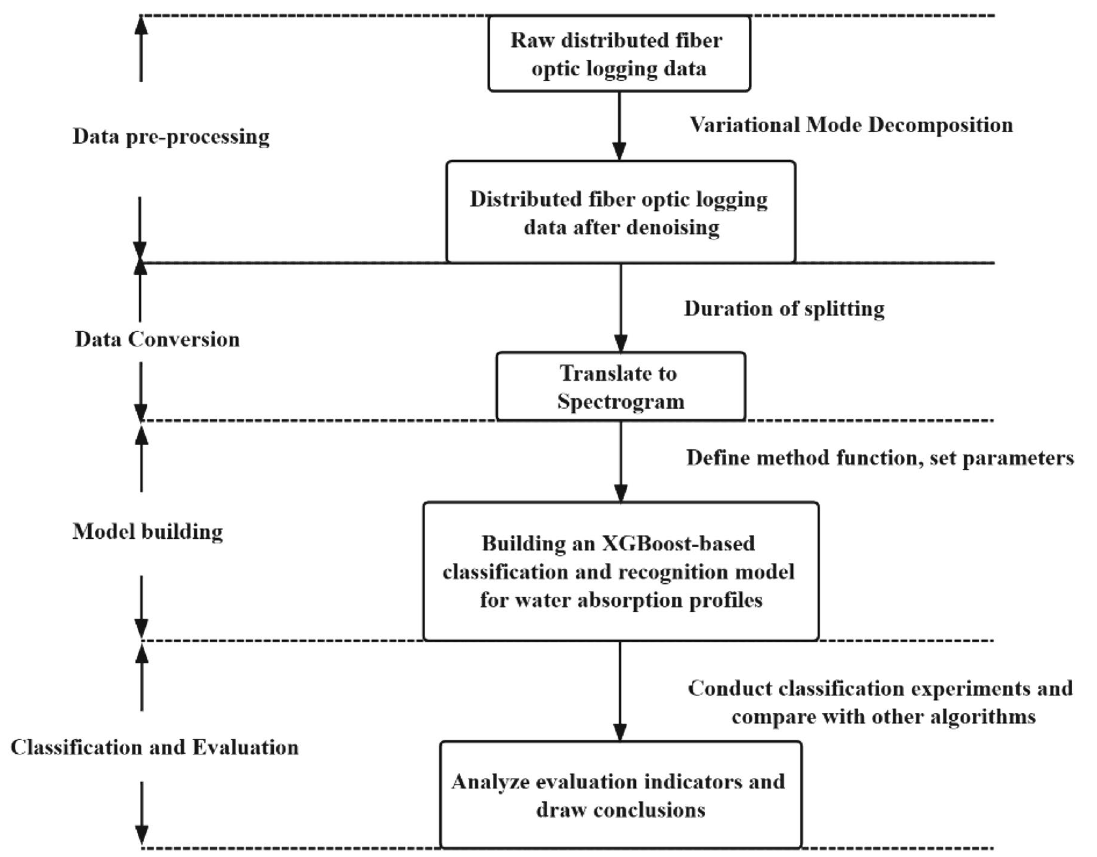
Fig. 1 Distributed fiber optic vibration signal identification classification absorption profile flow